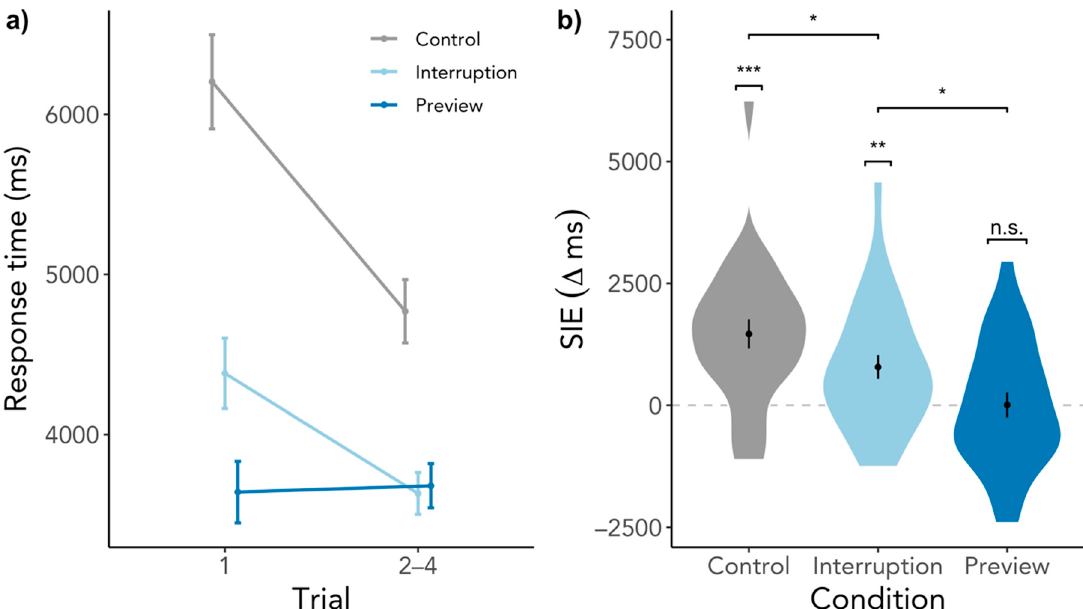
Figure 5. SIE in response times only for trials in which the target object has been fixated previously. ( a ) depicts the response times for the first trial in a scene visit and the average of the response times of the second to the fourth trial. ( b ) shows the difference between the response time of the first trial and the average of the second to the fourth trial. Higher values indicate a larger response time for the first trial than the subsequent trials, while the dashed line indicates the point of no difference in response times between trials. Error bars indicate within-subject standard error. n.s. = not significant, * p < 0.05., ** p < 0.01, *** p < 0.001.